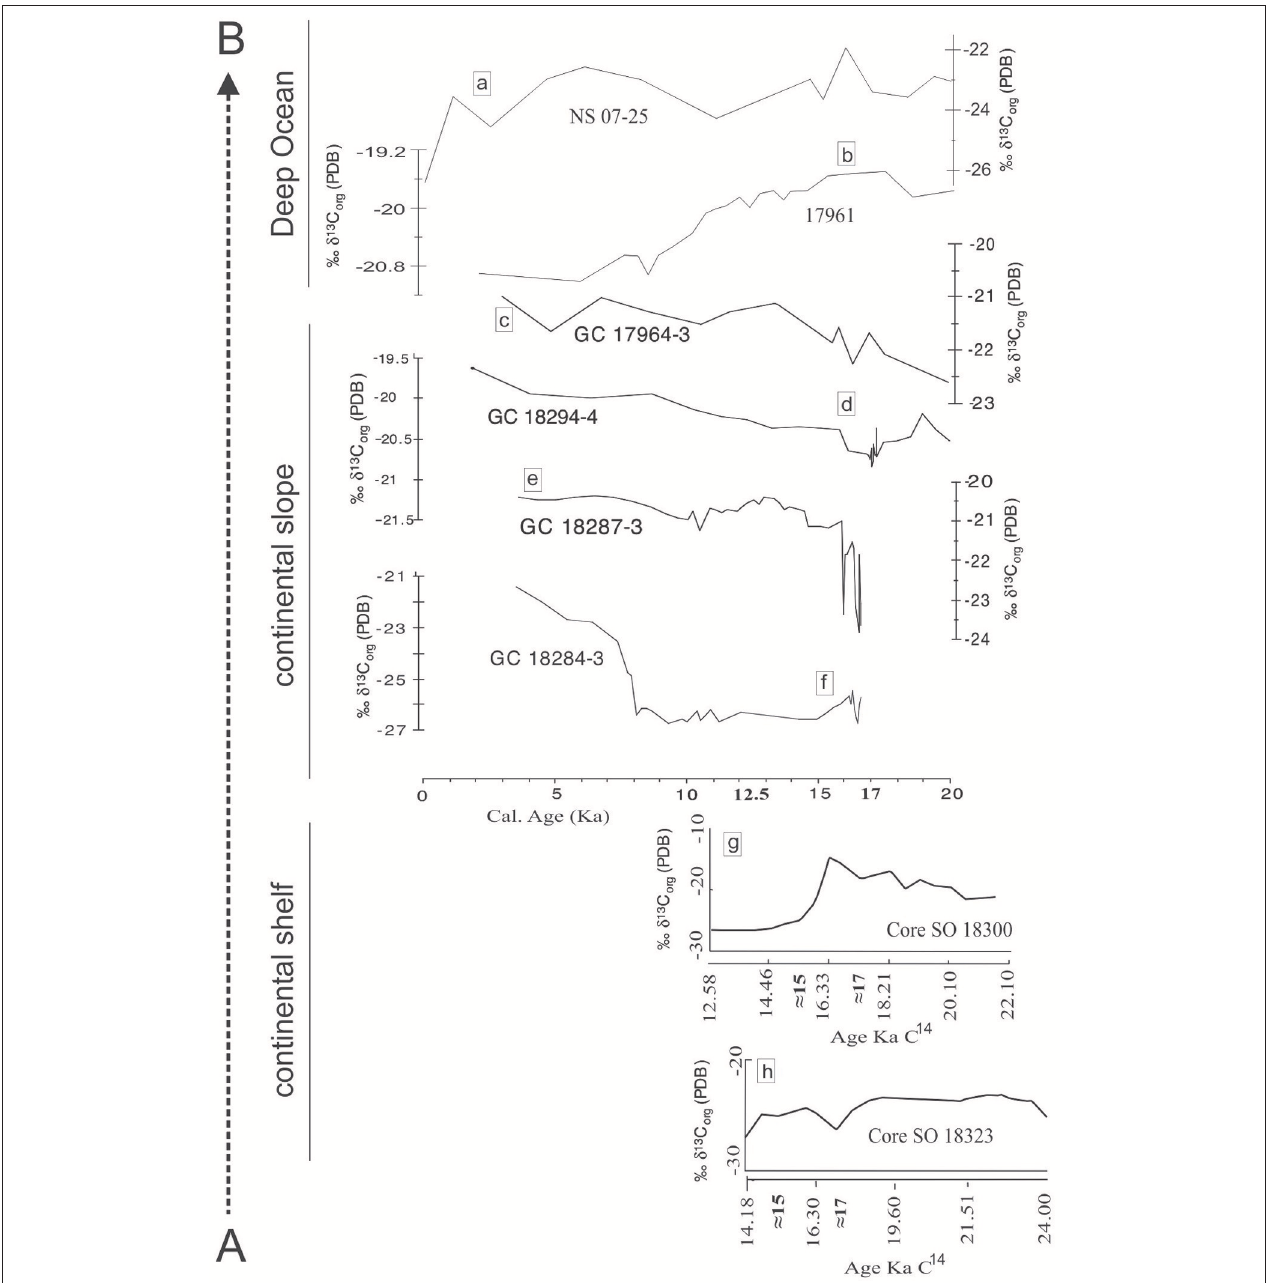
FIGURE 8 | δ 13 C org variation patterns along the transect AB ( Figure 1 ) from continental shelf to deep ocean for last 20Ka. Graph (8a) this study (NS 07-25) and Graph (8b) (Kienast et al., 2001) 17961 are from deep ocean. 8c–h were modified using original delta C13 graphs from research articles as mentioned below. 8c (GC 18284-3), 8d (GC 17964-3), 8e (GC 18294-4) and 8f (GC 18287-3) were taken from Steinke et al. (2003) representing continental slope. Figure 8 g (SO 18300) and 8h (SO 18323) were taken from Wang et al. (2009) representing continental